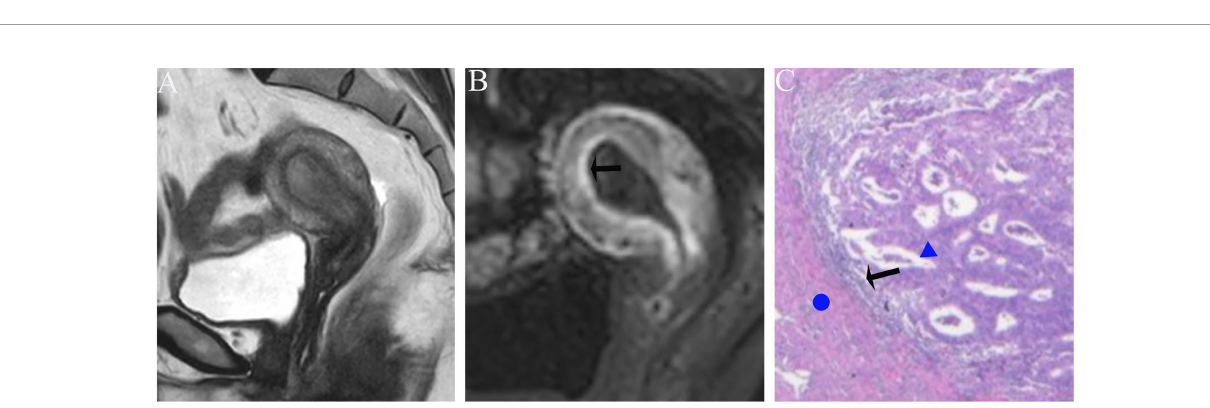
FIGURE 5 | (A) Sagittal-T2WI image, the tumor has moderate signal intensity and is found in the uterine cavity. (B) Early (32.9 s) sagittal-DCE image shows that the ITLPE seem to be visible at the anterior myometrium (black arrow). (C) A low-power photomicrograph (HE, 40×) shows the presence of endometrial stroma components (black arrow) between the tumor (triangle) and myometrium (circle). This case was histologically proven to have endometrioid carcinoma, G2 with no myometrial invasion, and was overestimated by